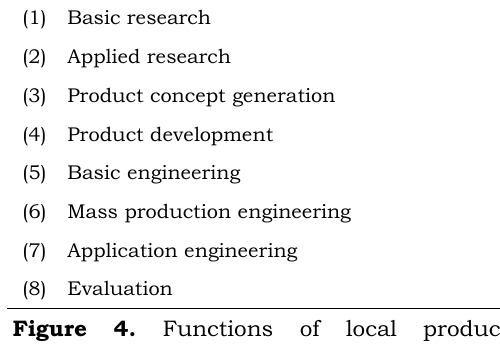
4. Functions of local product